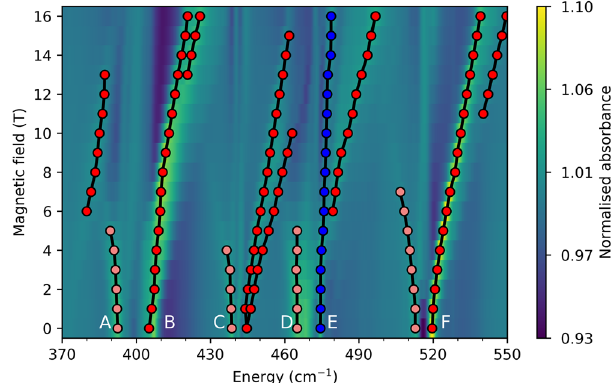
Fig. 5 Experimental FIRMS map for 1 with transitions highlighted. Experimental FIRMS map in the range 370 – 550cm − 1 , with purely electronic transitions shown in blue, and vibronic intra-KD transitions in red/pink (cold/hot). Assignments are based on ab initio simulation (Fig. 3c). Note that the weak fi eld-independent signals (vertical lines) may be pure vibrational modes, but as they appear at the turning points of the raw transmission spectra they could very well be instrumental